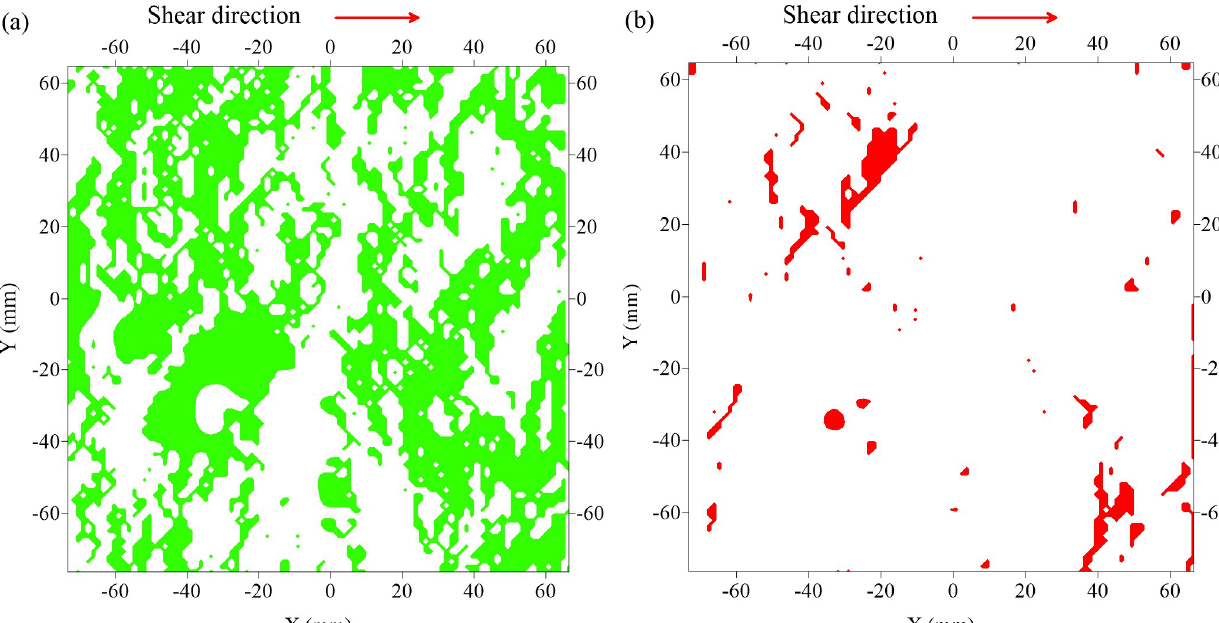
Figure 15. Two types of failure areas for shearing in the positive direction of the x axis. ( a ) Dilatancy failure area; ( b ) Fracture failure area.